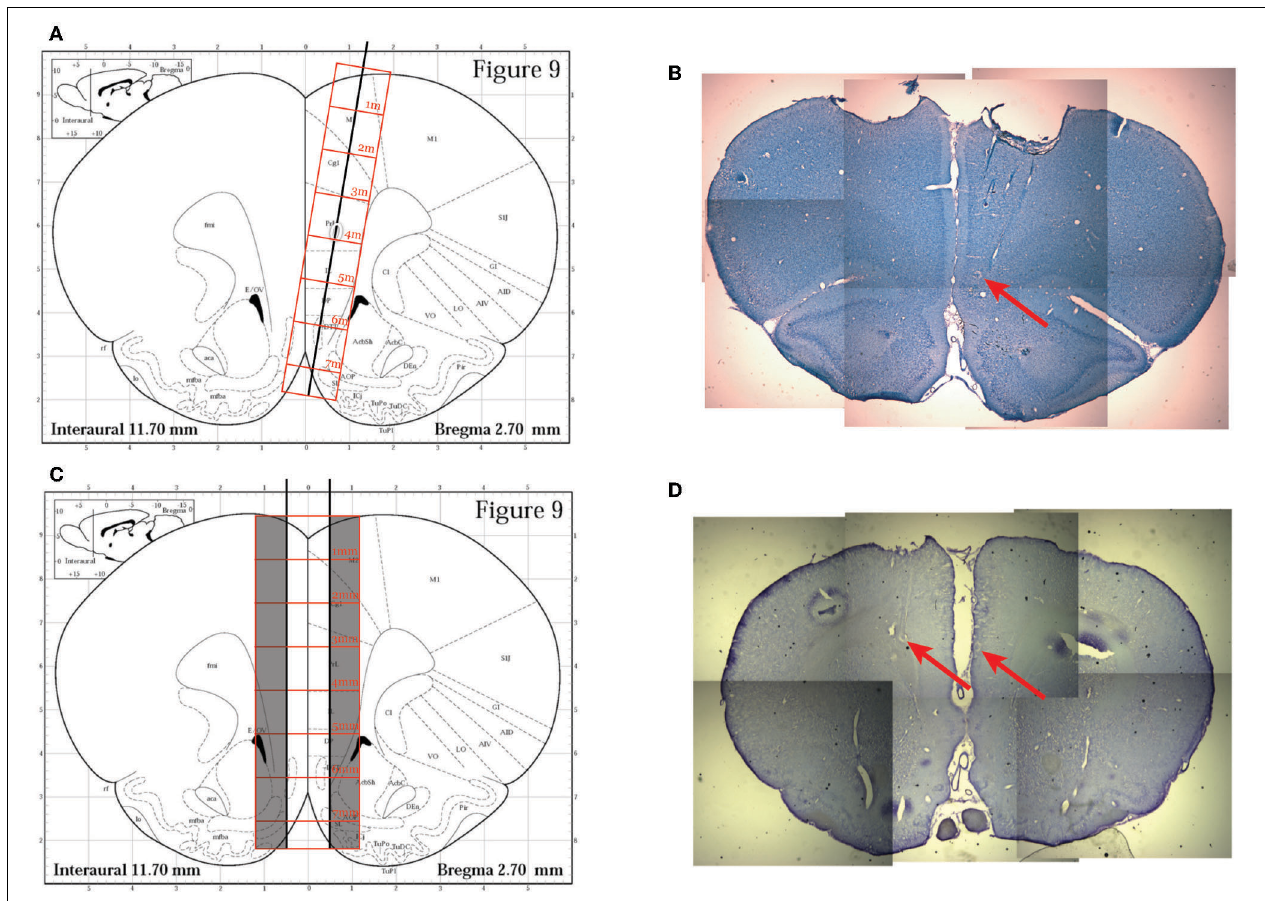
FIGURE 2 | Histology. (A) The original implantation technique used for the first rat (R193) based on the approach described in Euston and McNaughton (2006). A single bundle drive was implanted laterally and angled toward the midline. Image modified from Paxinos and Watson (1996). (B) A representative histology slice from rat R193 showing tetrode tracks and